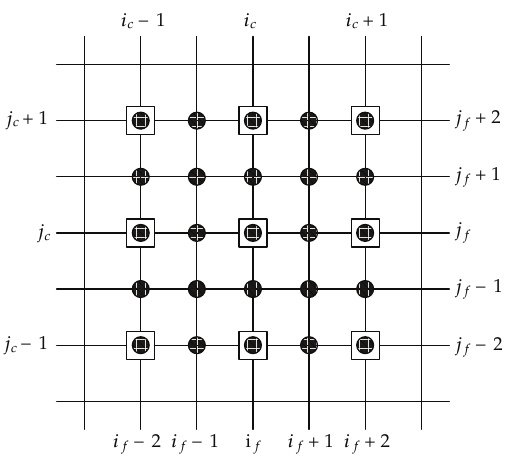
Figure 1: Structure of the double